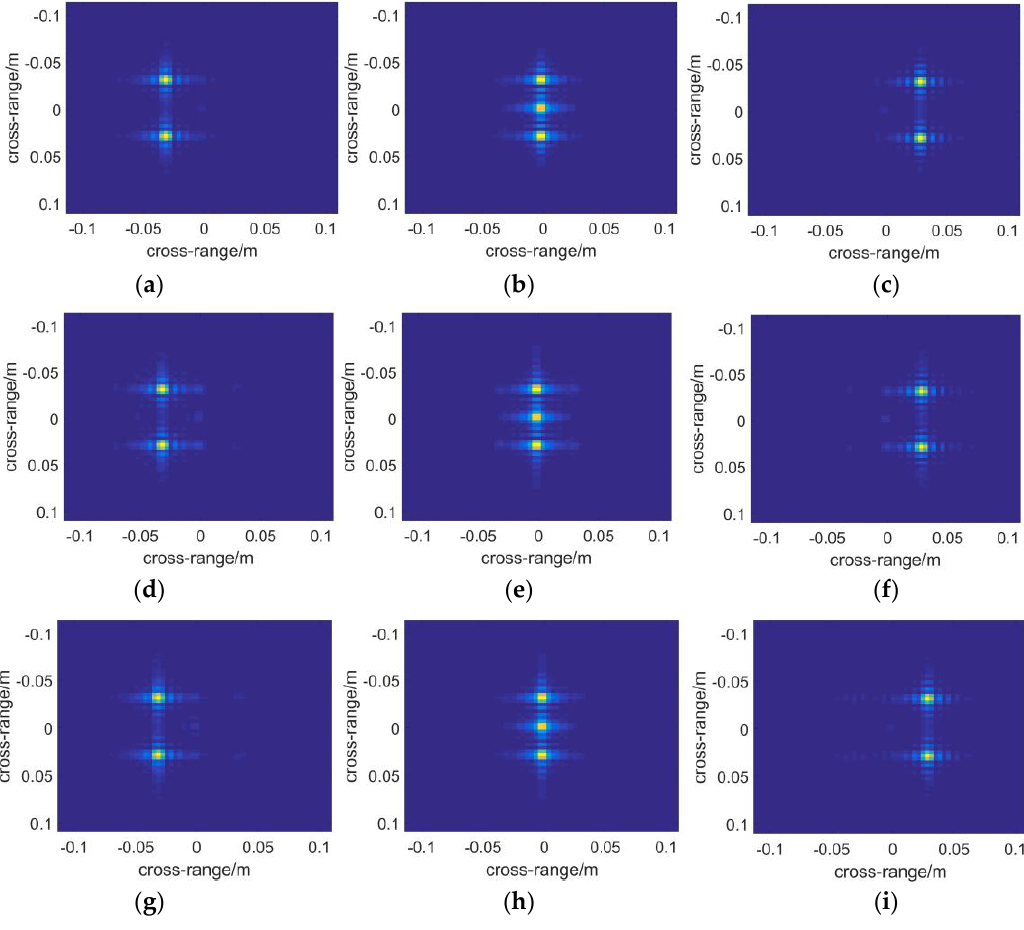
Figure 6. The slice figures along range direction of different distance with BPA, RMA and PMA for monostatic case respectively: ( a ) x = 0.03 with BPA; ( b ) x = 0 with BPA; ( c ) x = −0.03 with BPA; ( d ) x = 0.055 with RMA; ( e ) x = 0 with RMA; ( f ) x = −0.064 with RMA; ( g ) x = 0.03 with PMA; ( h ) x = 0 with PMA; ( i ) x = −0.03 with PMA.